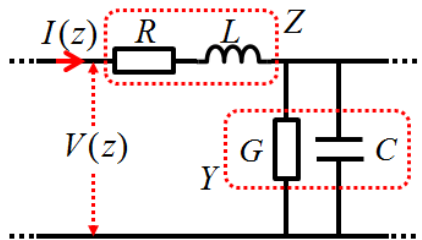
Figure 11: RLGC transmission line model